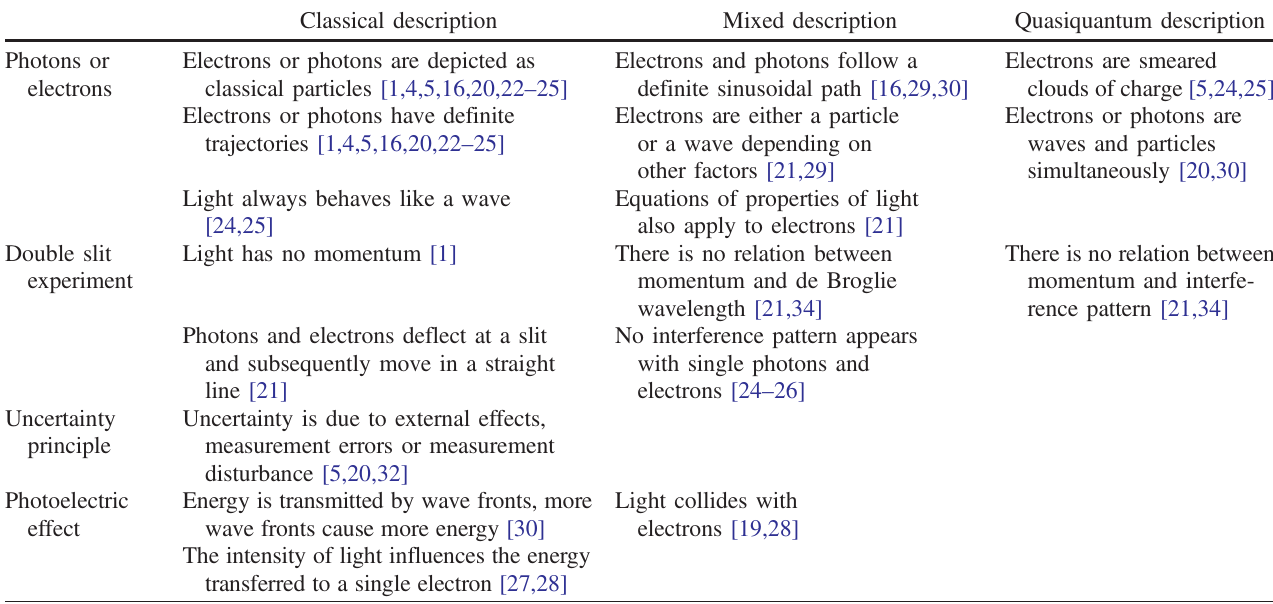
TABLE II. Misconceptions about wave-particle duality organized into three categories ranging from classical to quantum thinking. Classical